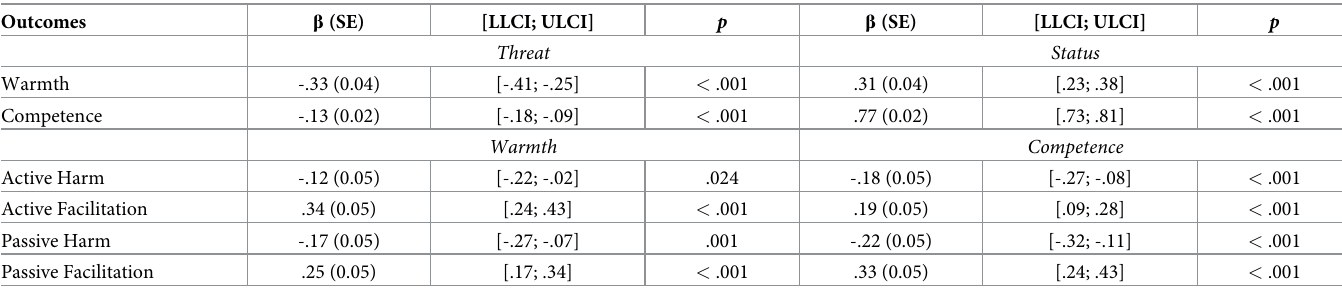
Table 2. Estimated effects of the modified path model.